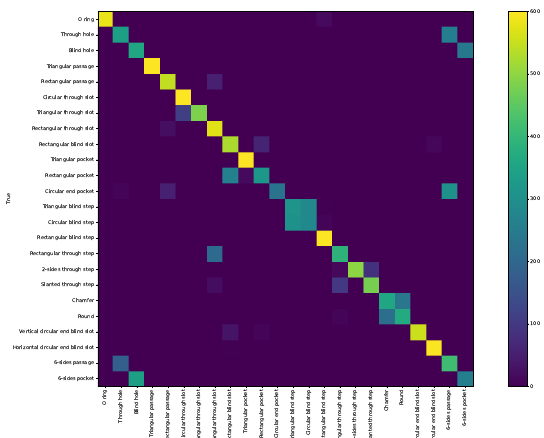
Figure A7. Confusion matrix for VoxNet